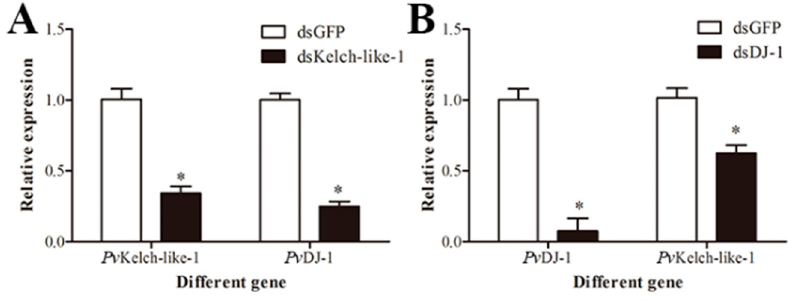
Figure 6. Regulatory relationship of Pv Kelch-like-1 and Pv DJ-1. ( A ) Expression of Pv DJ-1 in Pv Kelch-like-1-silenced shrimp; ( B ) expression of Pv Kelch-like-1 in Pv DJ-1-silenced shrimp. Vertical bars represent the mean ± SD ( n = 3). Asterisks indicate statistically significant differences ( p < 0.05) between the two treatment groups.